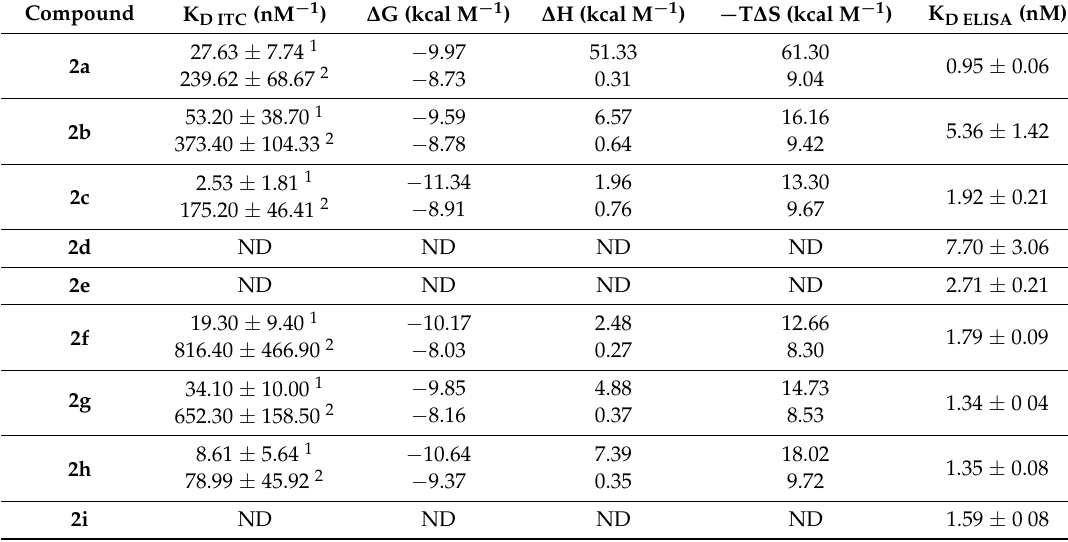
Table 1. Thermodynamic parameters as resulted from ITC analysis for compounds 2a – 2i and K D values from quantitative evaluation of ELISA